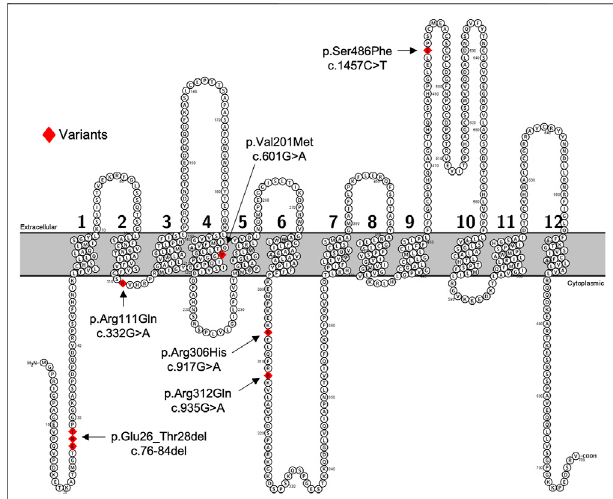
FIGURE 1 | Predicated 2-D structure of OATP2B1 full length transcriptional variant. Genetic variants of interest are highlighted in red and indicated by arrows with residue number and amino acid change. The predicted 2-dimensional membrane topology model of OATP2B1